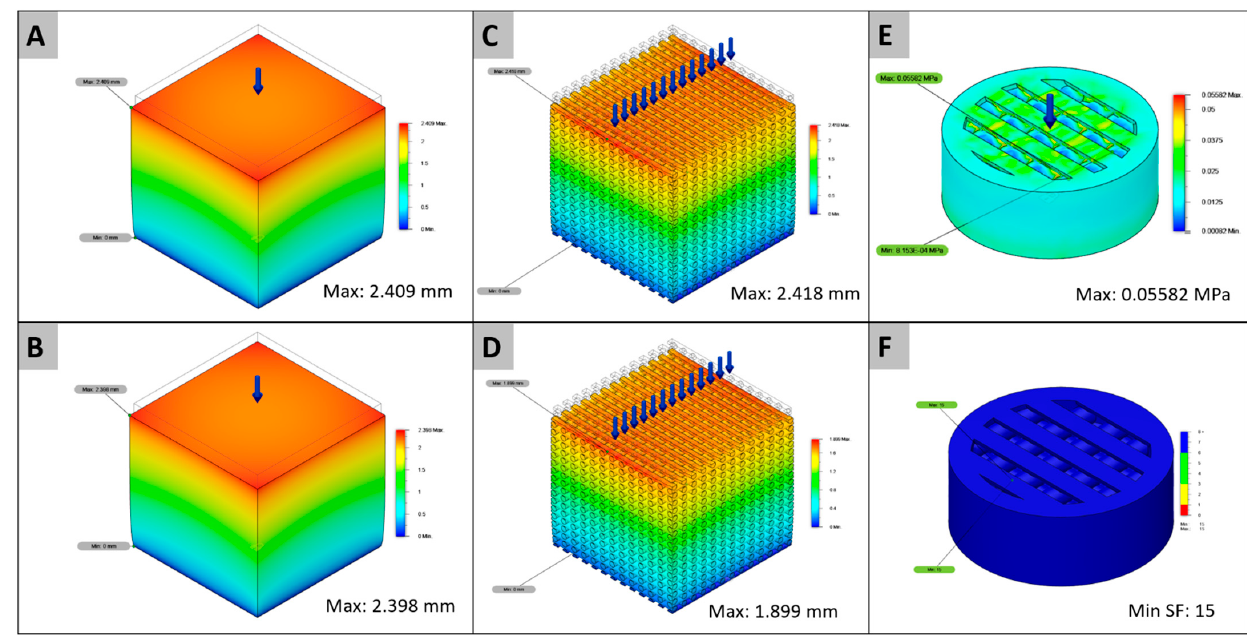
Figure 3. FEA Maximum displacements for PCL: ( A ) solid cubes and ( C ) porous cubes, PCL+BCP: ( B ) solid cubes and ( D ) porous cubes, ( E ) maximum stress for the implanted scaffold, and ( F ) minimum safety factor.